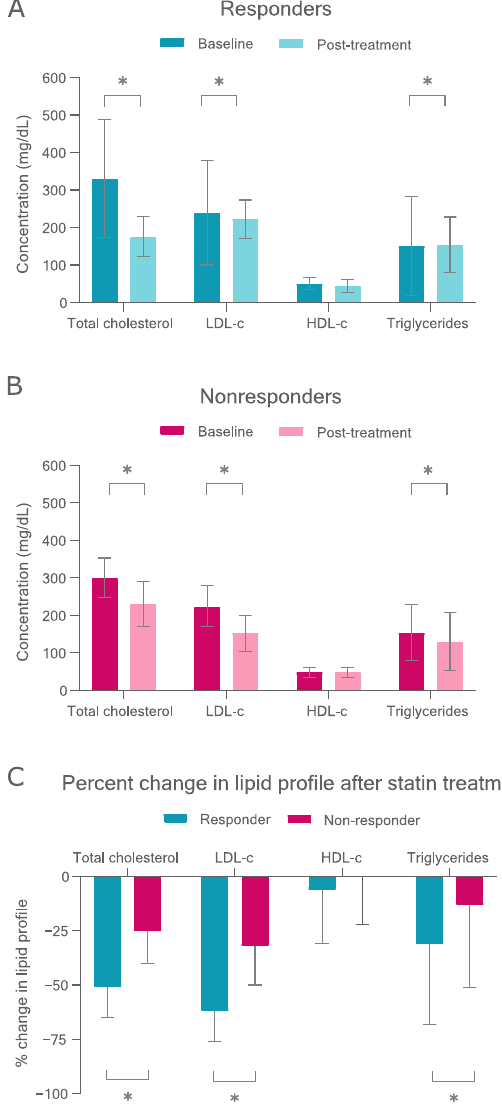
Figure 1. Plasma lipid profile in FH patients treated with lipid-lowering drugs. ( A ) Baseline and post-treatment mean values and standard deviation (SD) in responders (LDL-c reduction ≥ 50%). ( B ) Baseline and post-treatment mean values and SD in nonresponders (LDL-c reduction < 50%). ( C ) Plasma lipid response (mean values and SD of % change) in responder and nonresponder groups. * p < 0.05 (compared by t -test).